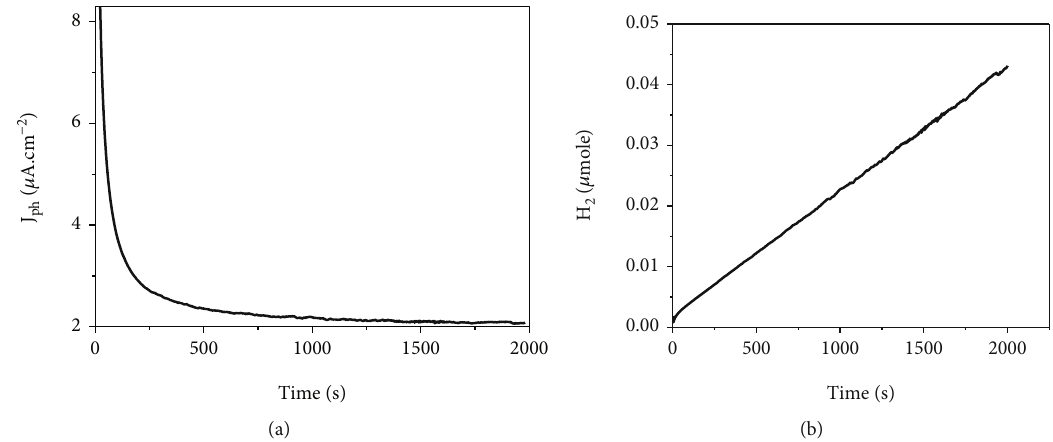
Figure 8: The relation between (a) the current density and time and (b) the produced H